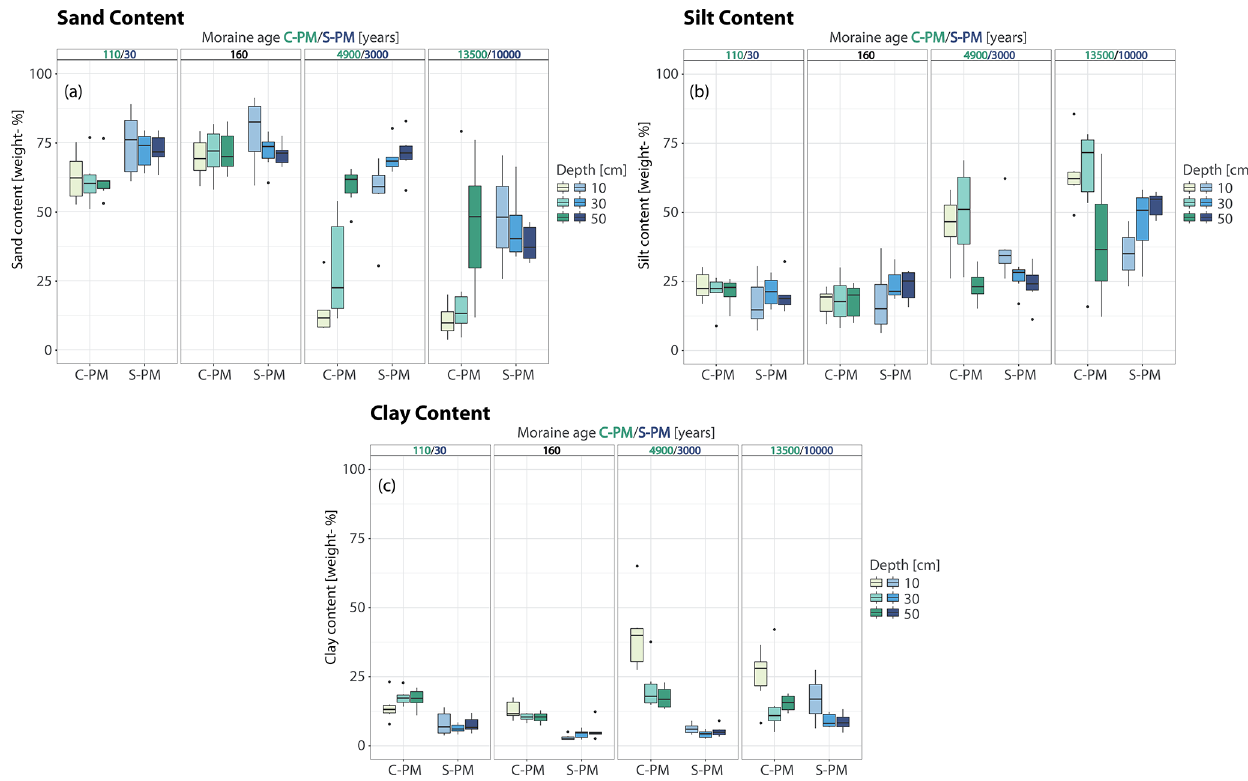
Figure 3. Development of sand, silt, and clay content at 10, 30, and 50cm over 10 millennia on silicate (S-PM, shown in blue color scale) and calcareous (C-PM, shown in green color scale) parent